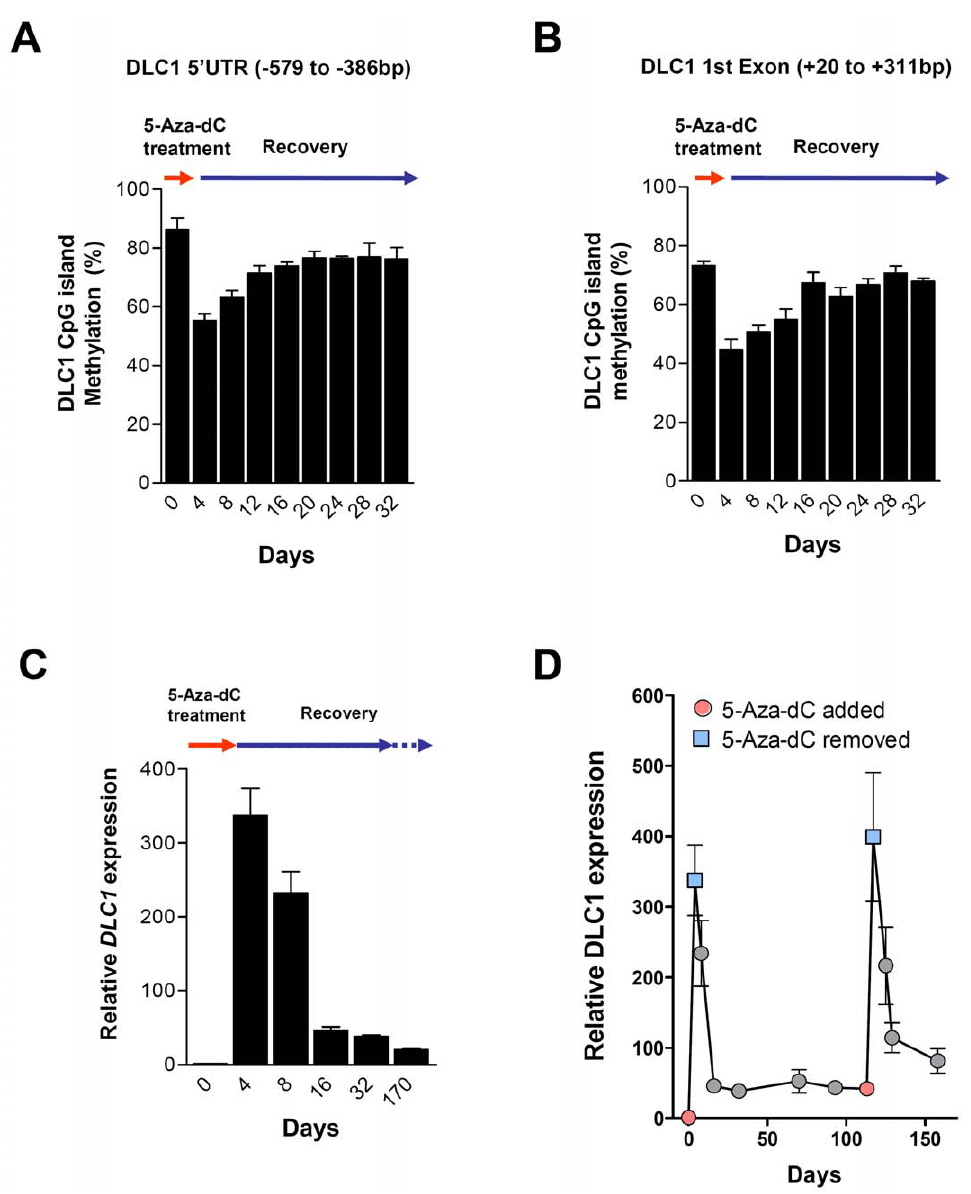
Figure 4. Incomplete DNA methylation recovery after 5-Aza-dC treatment. DLC1 CpG island methylation and mRNA expression in SMMC- 7721 cells during the 5-Aza-dC treatment (Day 0 to Day 4) and recovery (Day 4 to Day 170) were determined. Approximately 10% of the overall DNA methylation on the DLC1 5 9 UTR (A) and 1 st exon (B) was permanently lost after 5-Aza-dC treatment. Quantitatively analysis was done by pyrosequencing, and the average methylation of 10 and 8 CpG dinucleotides on 5 9 UTR and first exon, respectively, was obtained from three independent experiments and is presented as mean 6 SEM. (C). Consistently, a low level of residual DLC1 gene expression in 5-Aza-dC-recovered cells could be detected in SMMC-7721 cells (up to 170 days). (D). Residual DLC1 gene expression was significantly higher (P=0.0010, t-test) in the 5-Aza- dC-recovered cells that were re-administered with 5-Aza-dC (comparing day 16 and day 129, i.e. 12 days after 1 st and 2 nd 5-Aza-dC treatment), suggesting that multiple administrations may be required to ensure complete demethylation of tumor suppressor genes following treatment with 5- Aza-dC. Opened circles and rectangles indicate the start and the end of 5-Aza-dC treatment, respectively (Mean 6 SEM, N=4).